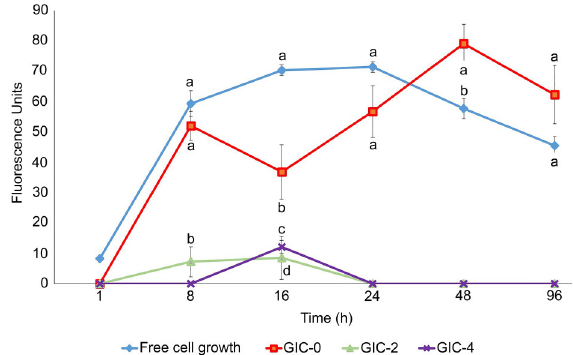
Figure 2. Growth of S. mutans as a function of time for glass ionomer cement (GIC) modi fi ed with thymol at different concen- trations: 0, 2, and 4%. Data are reported as mean ± SD. Different letters indicate signi fi cant differences between groups (P o 0.05, ANOVA and Tukey ’ s